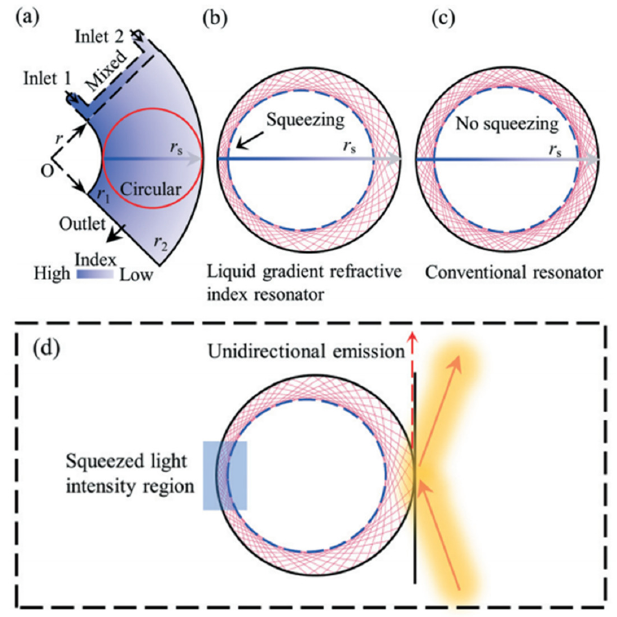
Figure 33. Schematic of a liquid–diffusion optofluidic gradient index resonator. ( a ) The optofluidic diffusing structure, ( b ) ray trajectory squeezed and ( c ) ray trajectories are symmetrical in a conventional circular cavity. ( d ) Squeezing the light intensity profile enables unidirectional emissions on the low refractive index side [138]. Reprinted with permission from Ref. [138]. 2020 Royal Society of Chemistry.